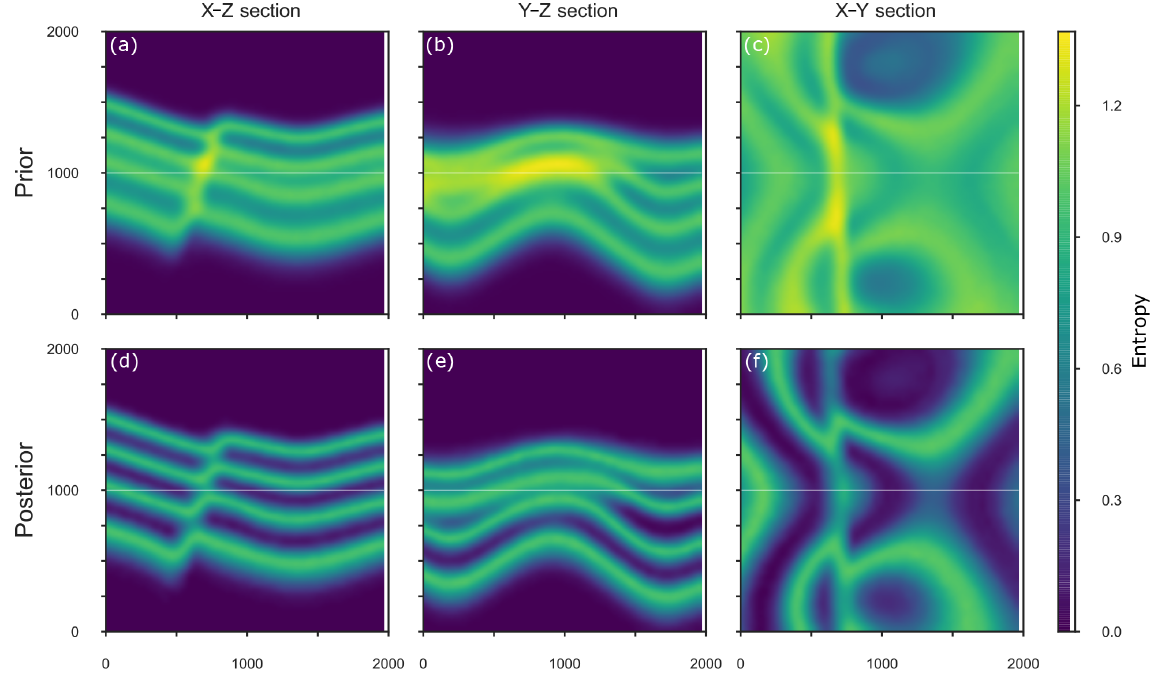
Figure 6. Shannon entropy slices in the X–Z (a, d) , Y–X (b, e) and X–Y plane of the prior (top, a–c ) and posterior (bottom, d–f ) geomodel ensemble. The white lines show the location of other respective cross sections.